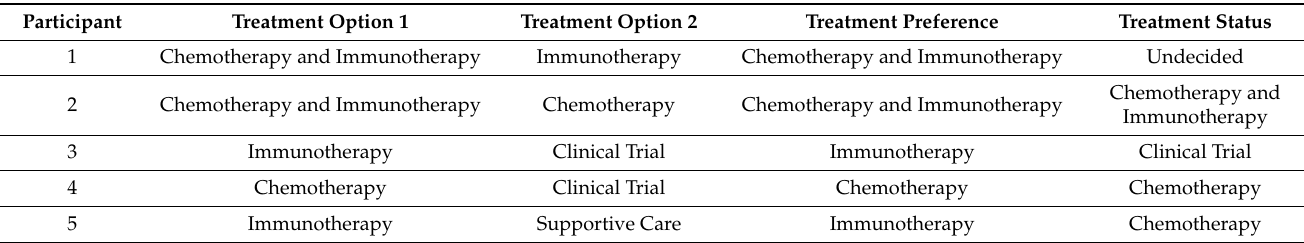
Table 5. Recommended treatment options, preference, and status at 30